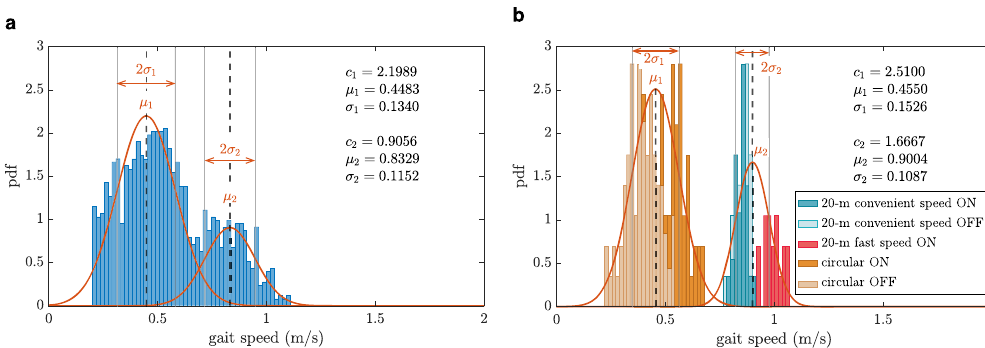
Fig. 2 An example of the gait speed probability density function (pdf) for one of the patients (P6). The distribution is shown at ( a ) home and ( b ) at the clinic. The red fi tted curves are the fi rst and second terms of the bimodal Gaussian distribution introduced by Eq. 1, the parameters c 1 , c 2 , μ 1 , μ 2 , σ 1 , and σ 2 are the Gaussian mixture model parameters de fi ned in Eq. 1.